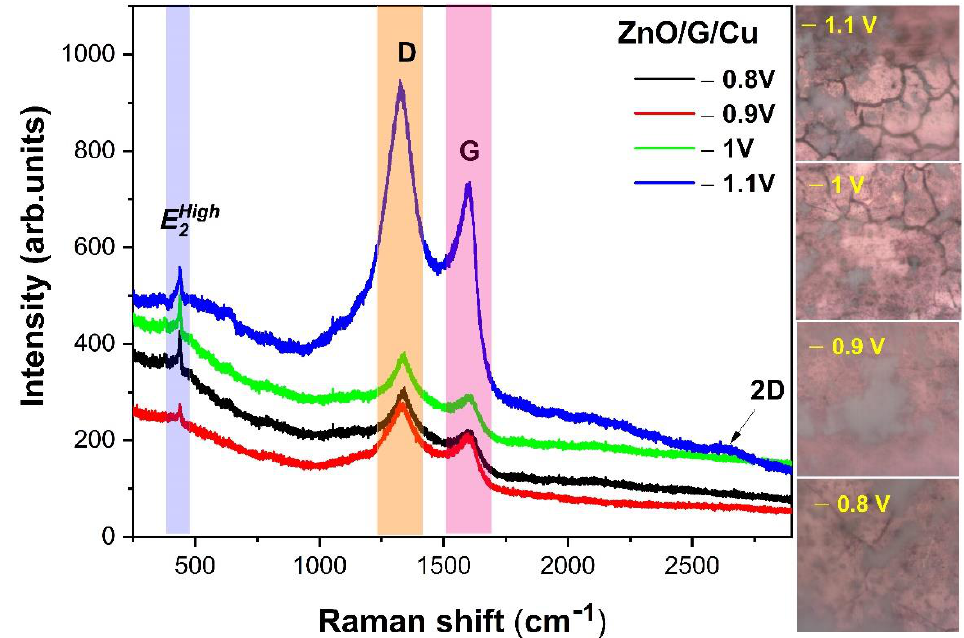
Figure 9. Raman spectra and images of the ZnO/G/Cu films deposited at − 0.8 V, −0 .9 V, −1 V, and −1 .1 V vs. RE.